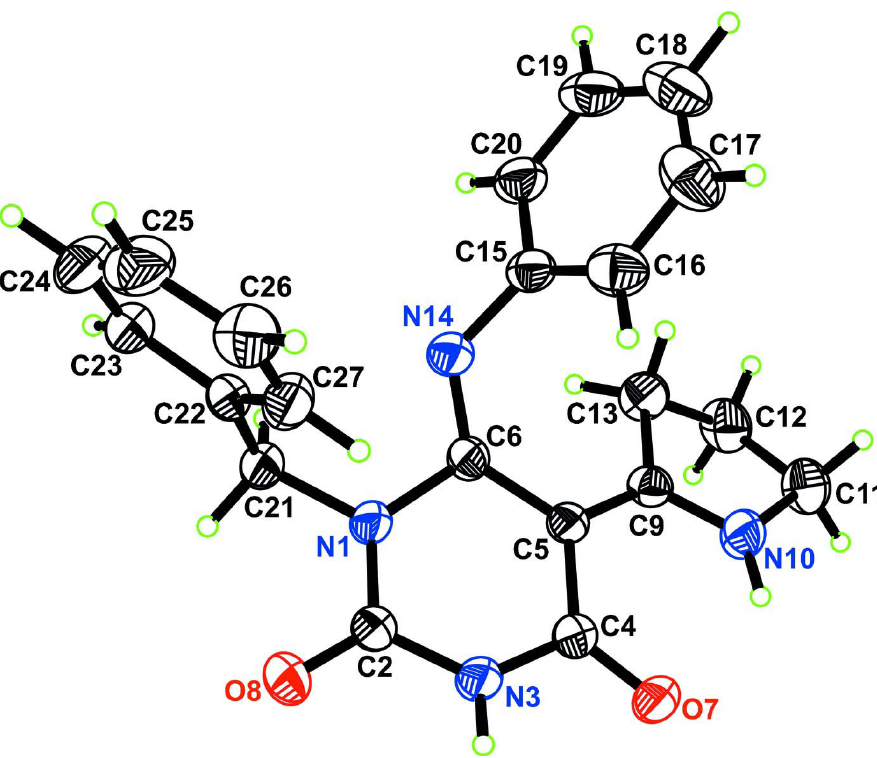
A view of (I) with the atomic numbering scheme. Displacement ellipsoids are drawn at the 50% probability